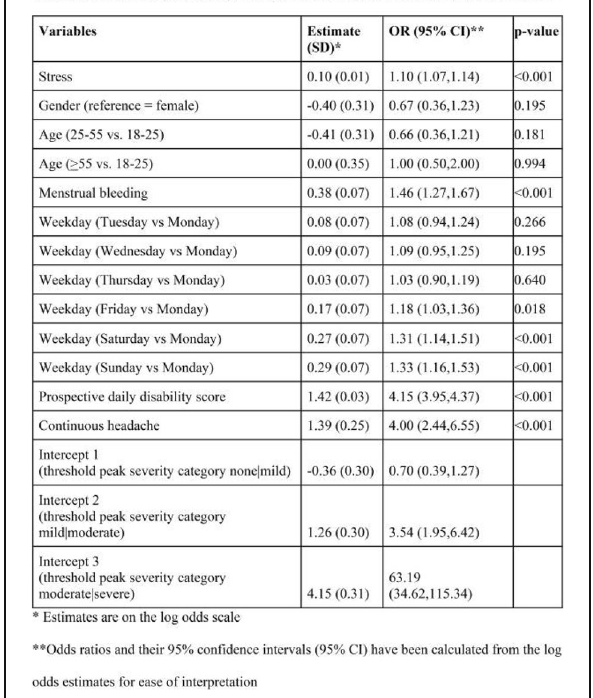
Fig. 1 (abstract P0370). See text for description